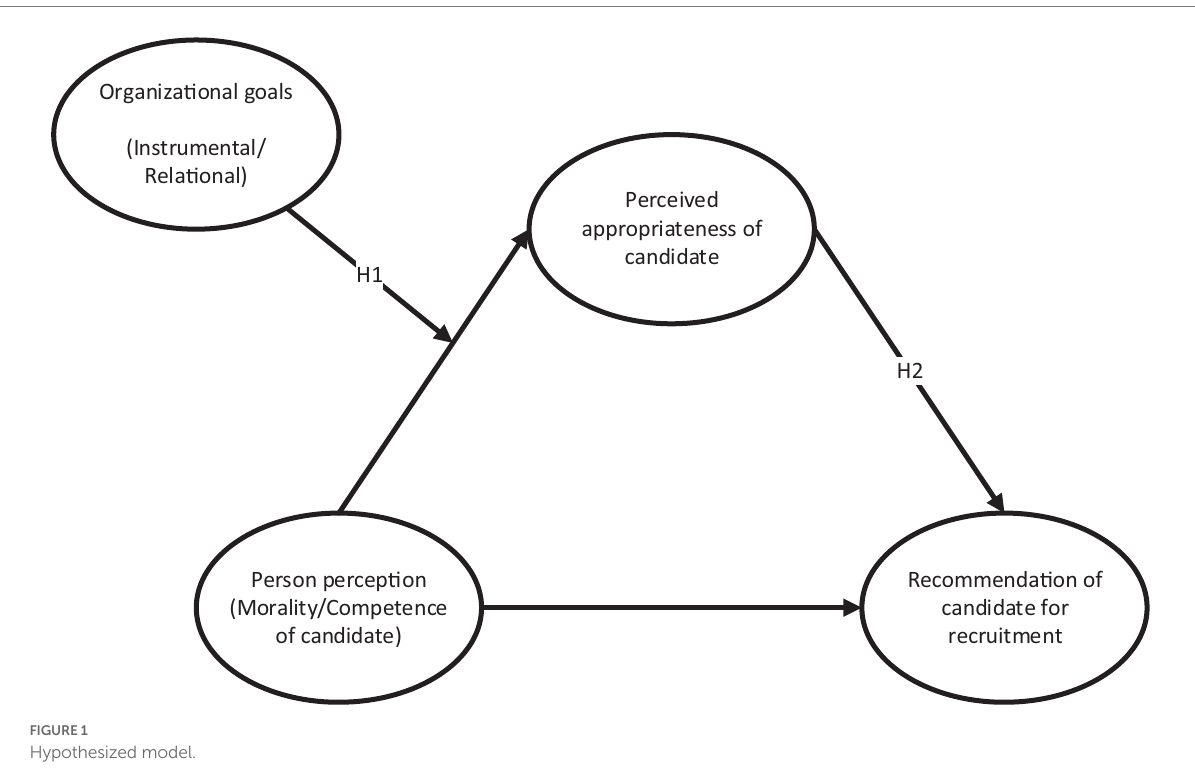
FIGURE 1 Hypothesized